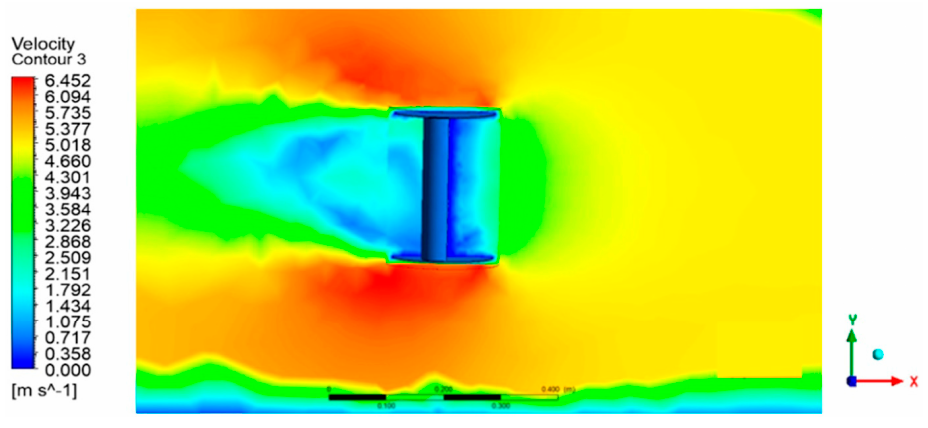
Figure 3. Actual Savonius rotor blade.